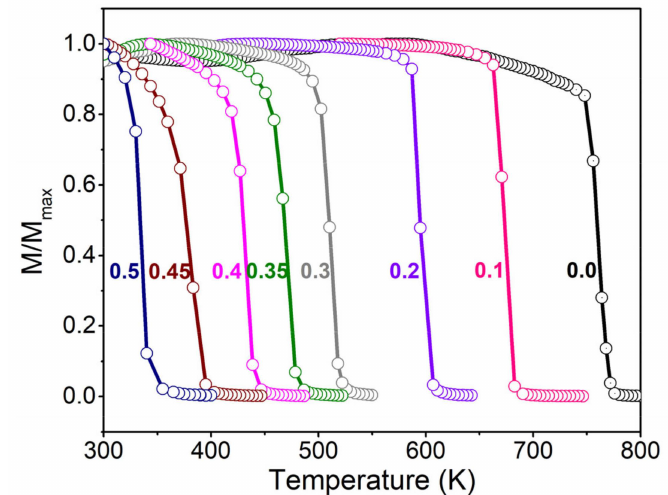
Figure 2. (Color online). The normalized magnetization versus temperature curves for Co(Fe 1 − x Al x ) 2 O 4 ( x = 0.0, 0.1, 0.2, 0.3, 0.35, 0.4, 0.45,